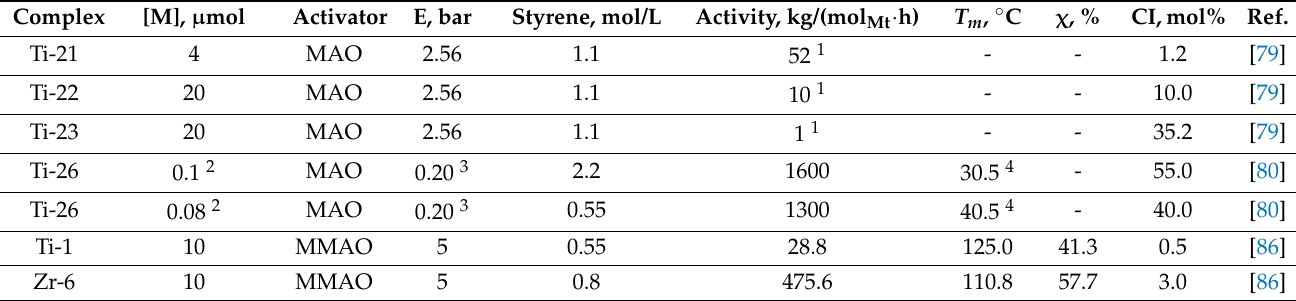
Figure 7. Complexes investigated as precatalysts for copolymerization of ethylene with alkyl derivatives of styrene or α , ω -alkenols [82,83,87]. Table 6. Ethylene/styrene copolymerization